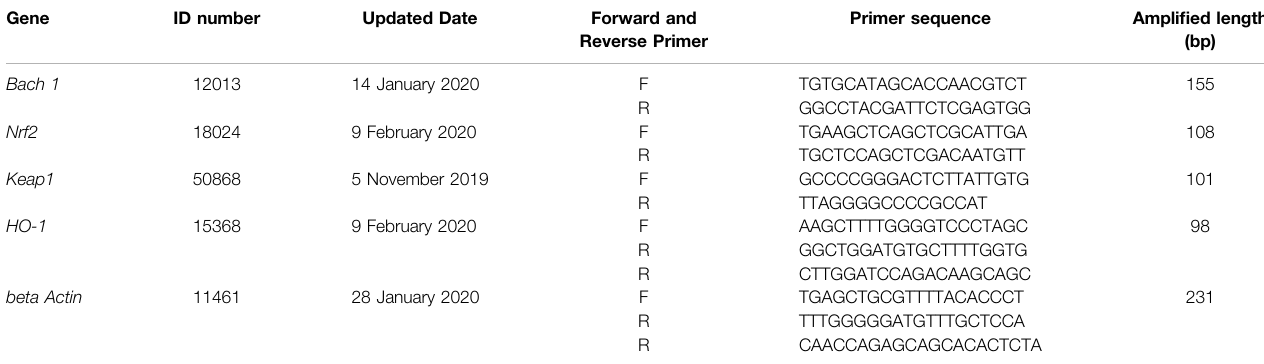
TABLE 2 | The quantitative real-time RT-PCR